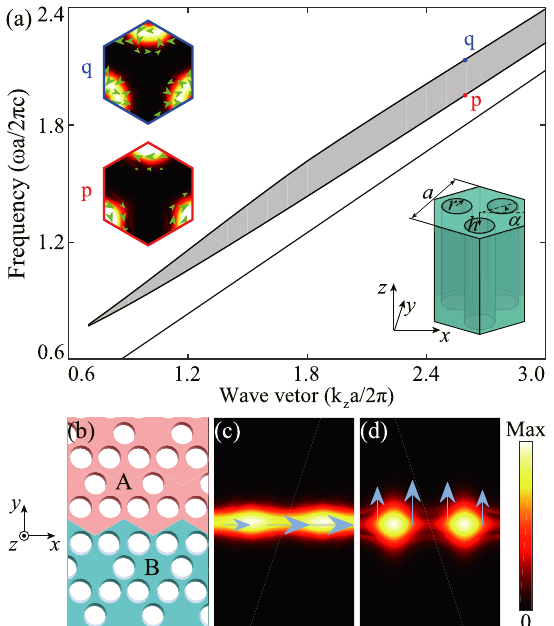
. (a) Figure 1: Topological gap and edge states with a non-zero k z varies. The black line Topological bandgap (gray region) as k z indicates the dispersion of the substrate material. The downright inset shows the three-hole unit. The top left insets are the electric field distributions of lower and upper bands at K point correspond to labels p and q , respectively. The green cones denote the Poynting vectors. (b) Interface formed by the upper phase A and lower phase B. (c) Electric field distribution of the horizontally polarized edge state. (d) Electric field distribution of the vertically polarized edge state. The blue arrows indicate the polarization